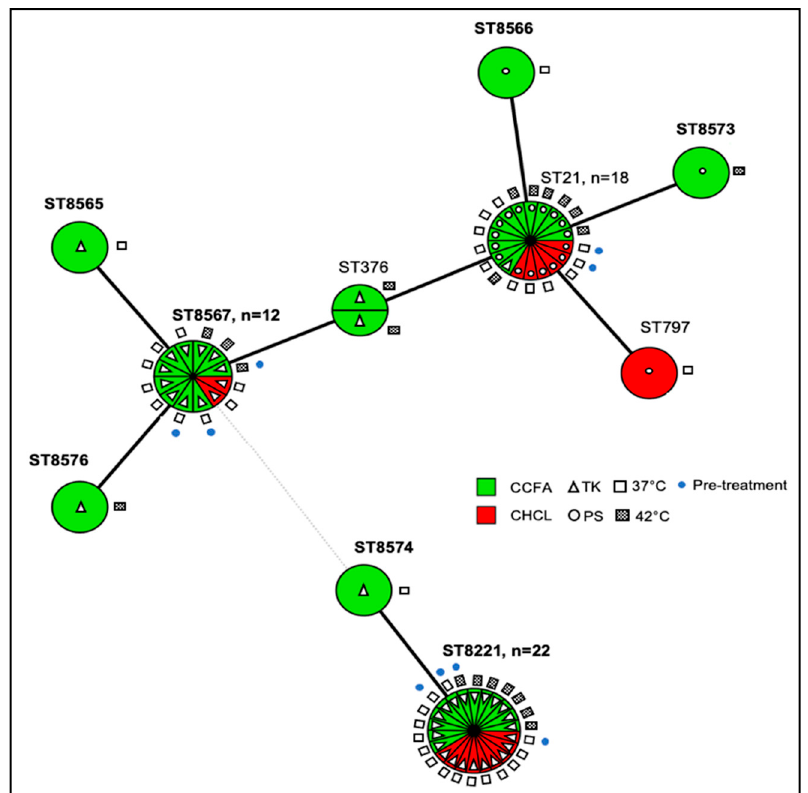
Figure 5. Minimum spanning tree (MST) demonstrating multilocus sequence typing (MLST)-based sequence types (STs) in C. jejuni from the CCFA and CHCL treatment groups. Each ST is represented by a circle, and partitions within each circle represent individual isolates with the respective ST. Circles without partitions (e.g., ST-797) indicate STs encountered only once. Green and red indicate the CCFA and CHCL group, respectively. AMR profile abbreviations: TK (rectangles), resistance only to tetracycline and kanamycin; PS (circles), pan-susceptible. Open and gray rectangles represent isolates obtained at 37 °C and 42 °C, respectively, and blue dots represent isolates recovered pre-treatment. Solid lines connect STs with a single-locus difference. The dashed line represents three or more allele differences, i.e., a different clonal complex (CC). STs above the dashed line belong to CC21, while the two STs below the dashed line belong to CC61. Novel STs are in bold. MLST analysis and MST construction were as described in Materials and Methods.